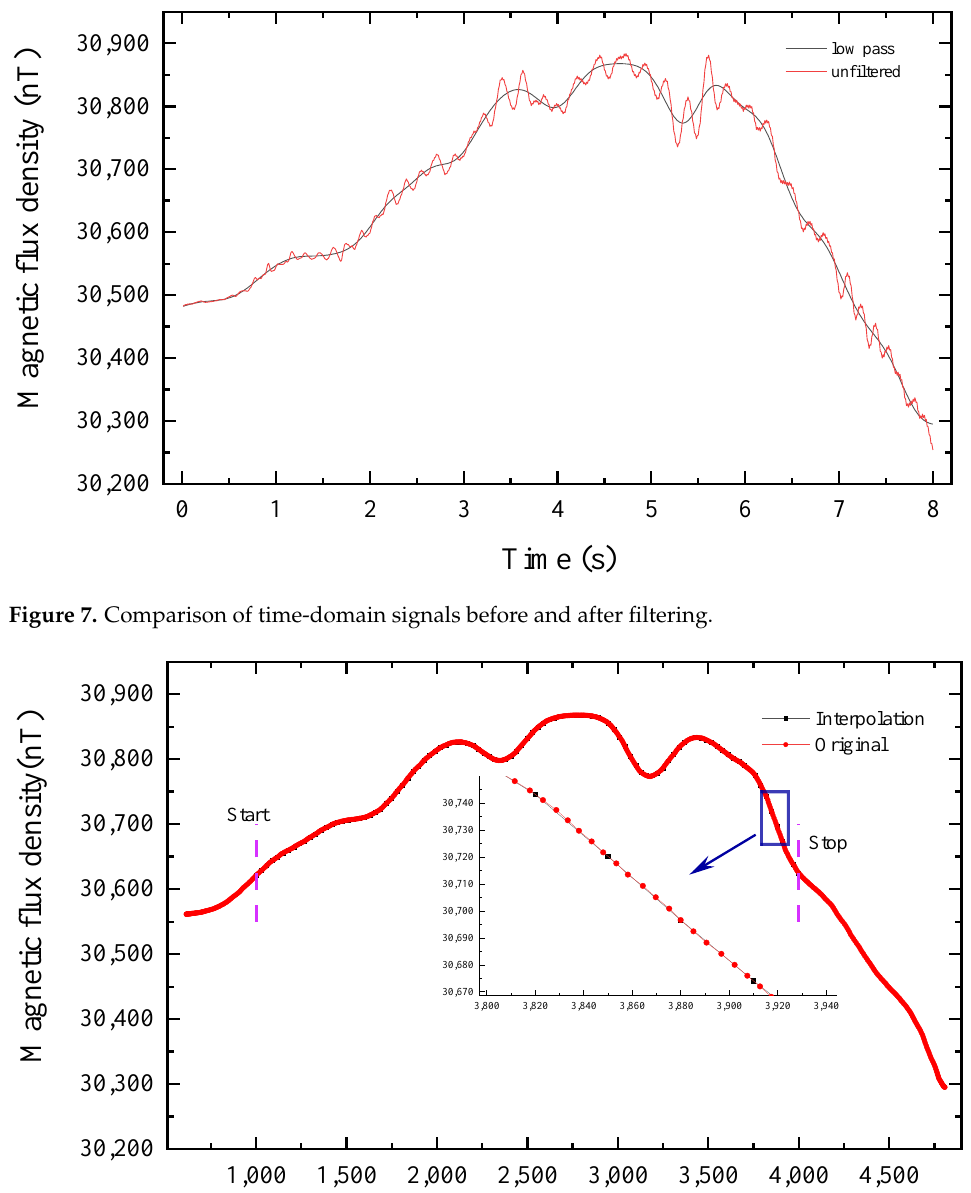
10 of 20 Figure 6. Butterworth Low-Pass Filter Frequency Response and Phase Frequency Curves. We place the starting point of the magnetic tensor matrix at 1000 mm from the FMCAS to the laser distance sensor and the endpoint at 4000 mm. We divide 101 points evenly within a distance of 3000 mm and obtain the three-axis magnetic flux density out- put of each fluxgate magnetic sensor at these distance points. We use the position of the FMCAS as the independent variable and use the three-axis magnetic flux density of each fluxgate magnetic sensor as the dependent variable for the interpolation calculation. For